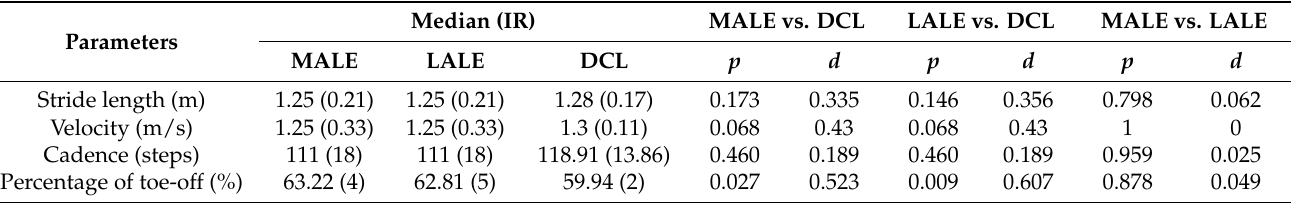
Table 2. Spatiotemporal parameters.